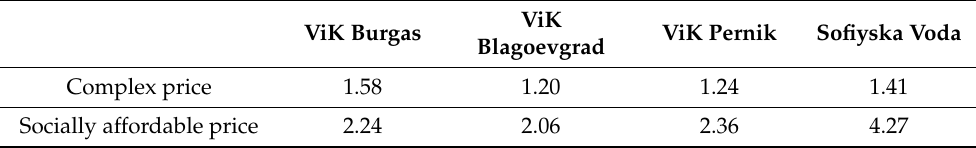
Table 3. Total cost of water services (in EUR) and the socially affordable price for the selected WSSOs as per